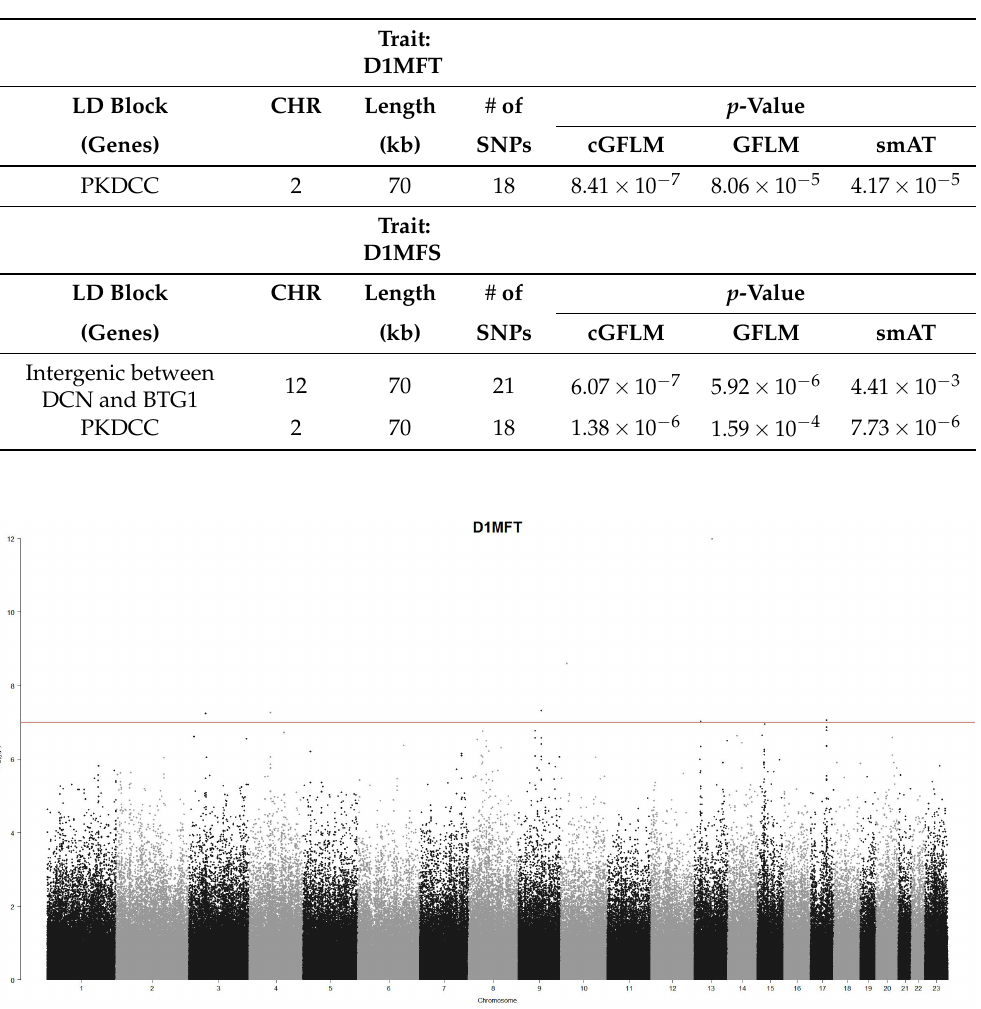
Table 5. Significant findings for dental caries association tests based on LD blocks (gene clusters) using the ZINB model (smAT-ZINB with Bonferroni correction, GFLM-ZINB, cGFLM-ZINB).